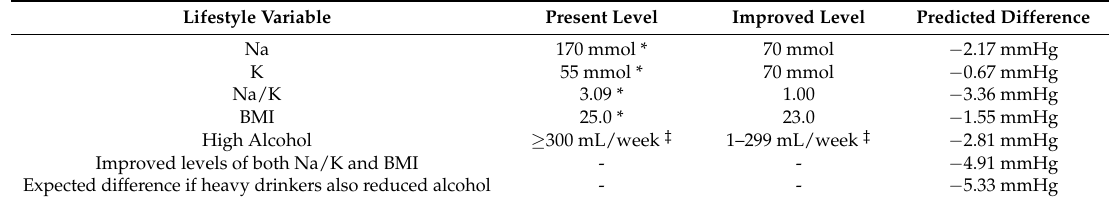
Table 1. Predicted differences in population mean systolic blood pressure with lifestyle